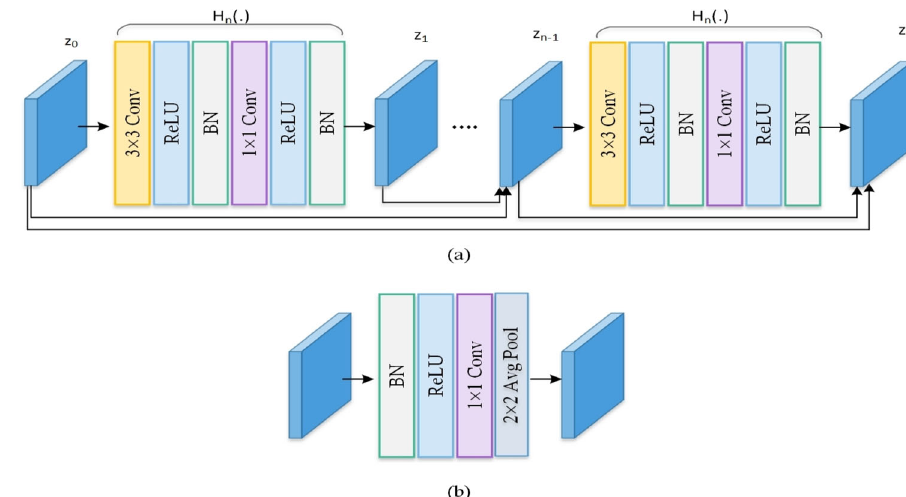
Fig. 3 The architecture of a dense block and b transition